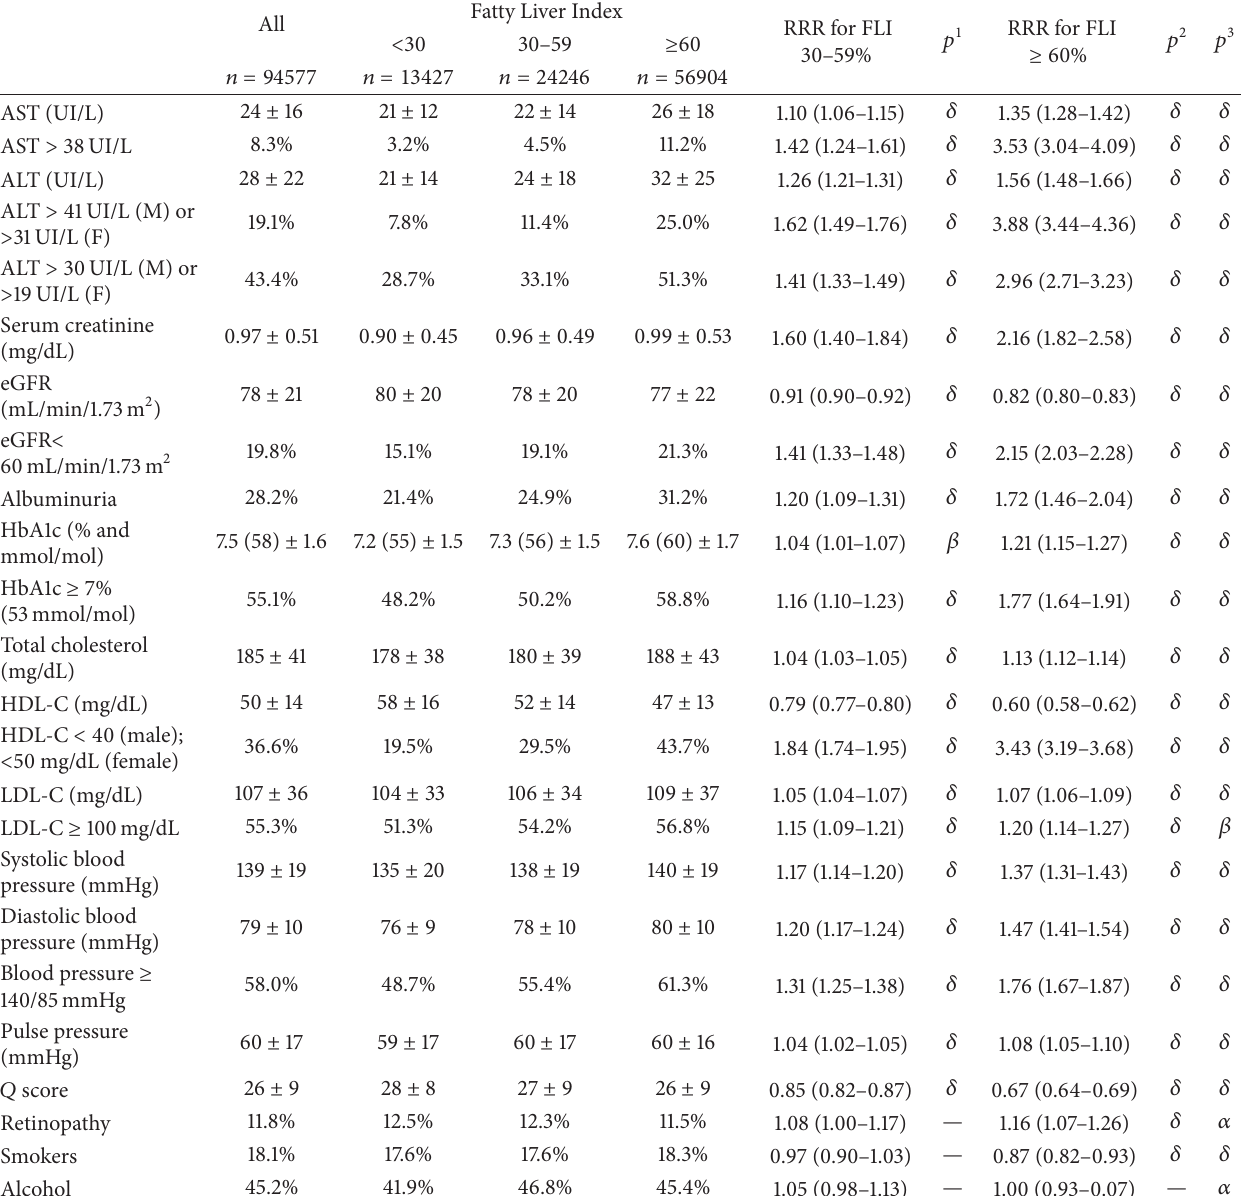
Table 3: Relative risk ratios adjusted for gender, age, and duration of diabetes for the overall